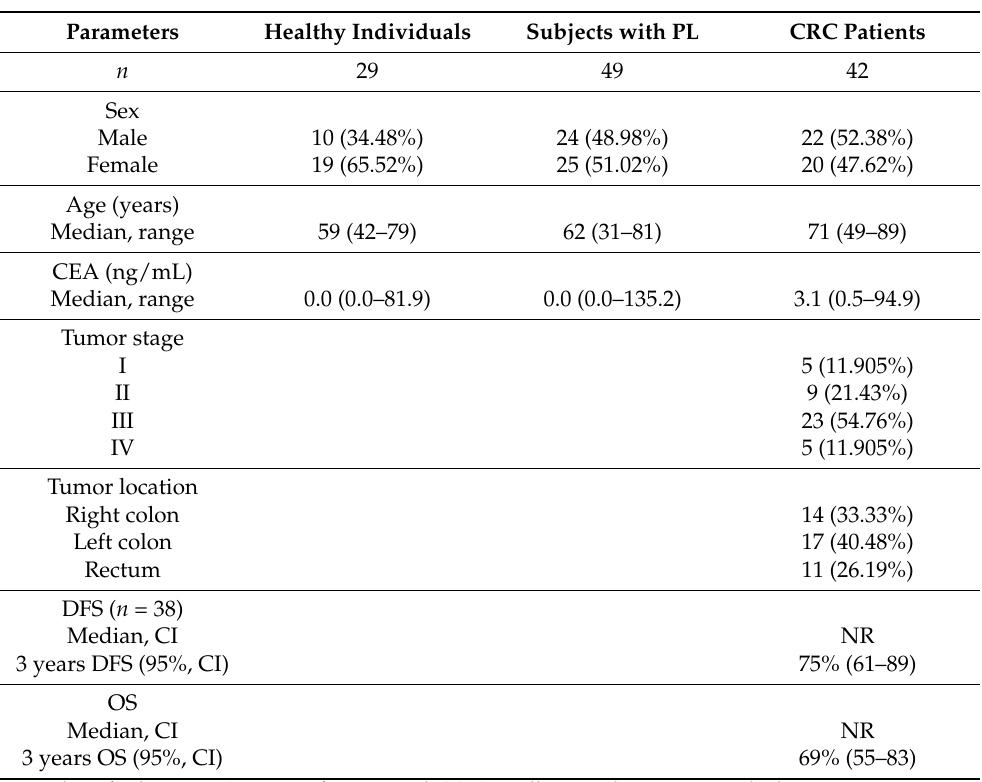
Table 1. Clinical parameters of the subjects included in the